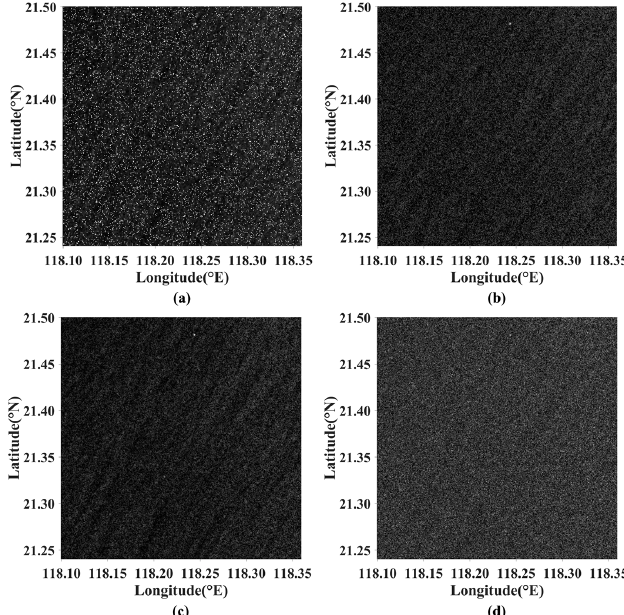
Figure 11. The image in Figure 2b is corrupted by each kind of noise: ( a ) salt-and-pepper noise (10% of contaminated pixels), ( b ) additive noise (SNR is − 10 dB), ( c ) multiplicative noise (variance of n’ is 0.4), ( d ) speckle noise.